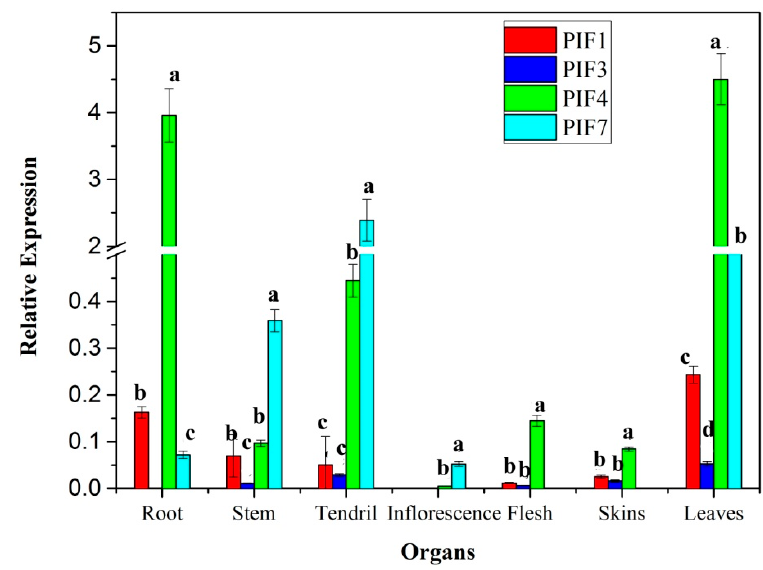
Figure 6. Relative expression levels of Vinitus vinifera phytochrome-interacting factors (VvPIFs) in different organs of Summer Black (SB). Values were normalized against the expression data of VvUBI gene and are given as means ± standard error among three biological replicates. Different letters indicate significant differences between genes ( p < 0.05) according to Duncan’s multiple test. The expression levels were calculated based on the 2 − △ Ct method.